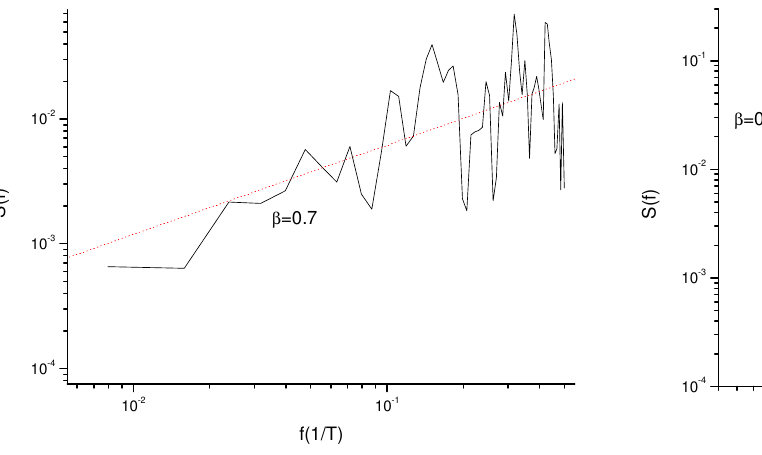
Fig. 6. Power spectrum of the shuffled increment time series.